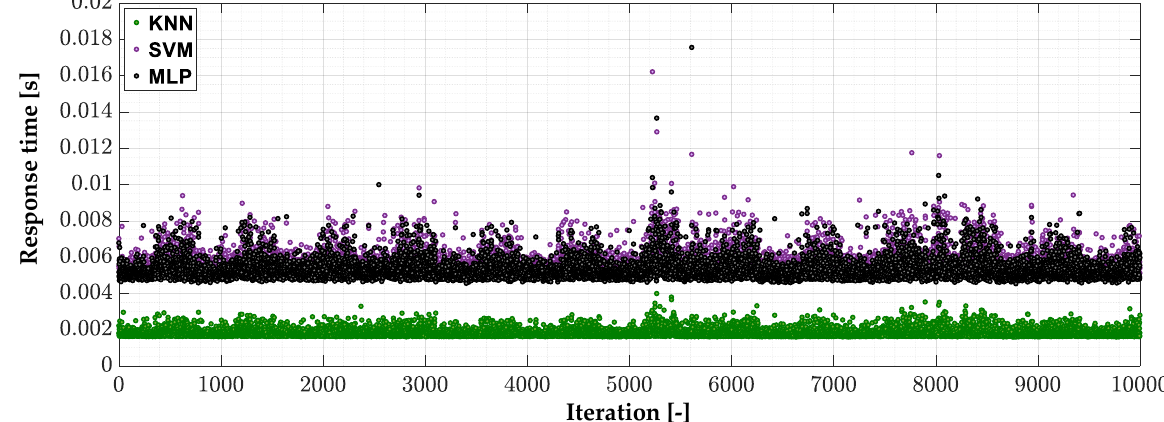
Figure 23. Comparison of the response time of the developed classifier models.